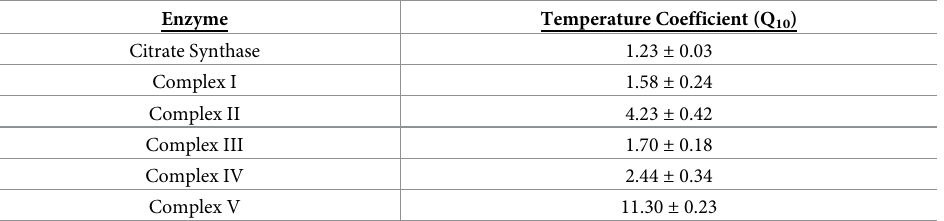
Table 2. Q 10 values for citrate synthase (CS) and ETS complexes I-V of whole mouse brain. Data were calculated from enzyme V max assayed at both 28 and 37˚C (Fig 2) and normalized to CS activity assayed at 37˚C. Data are mean ± SEM for n = 4 each.